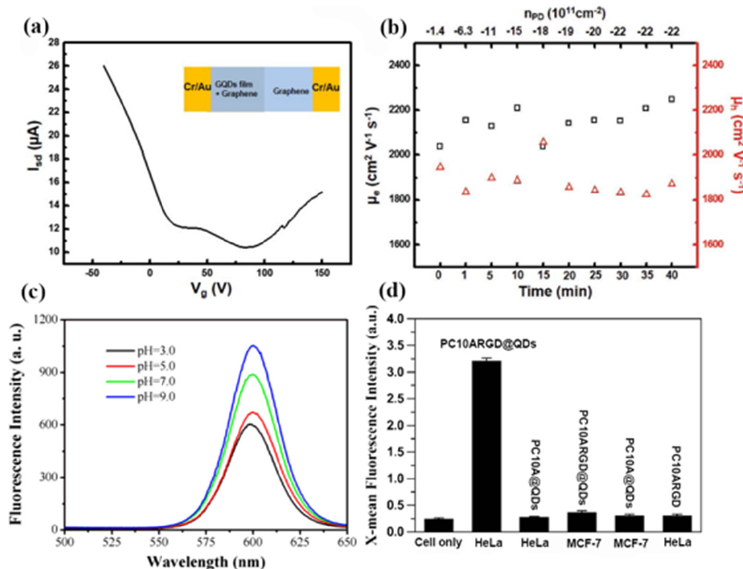
Figure 8. ( a ) Isd–Vg curve of graphene covering both of the partially deposited graphene QD film and SiO 2 device. ( b ) FET electron mobilities and hole mobilities of graphene/graphene QD film with respect to the increase in photoinduced doping (The triangles in the figure represent the mobility of the electron and the squares in the figure represent the mobility of hole.) [51]. Copyright 2017, Small . ( c ) Fluorescence spectra of PC10ARGD@QDs hybrid nanogels at different pH from 3 to 9. ( d ) Flow cytometry of HeLa and MCF-7 cells incubated with PC10A@QDs, PC10ARGD@QDs hybrid nano-